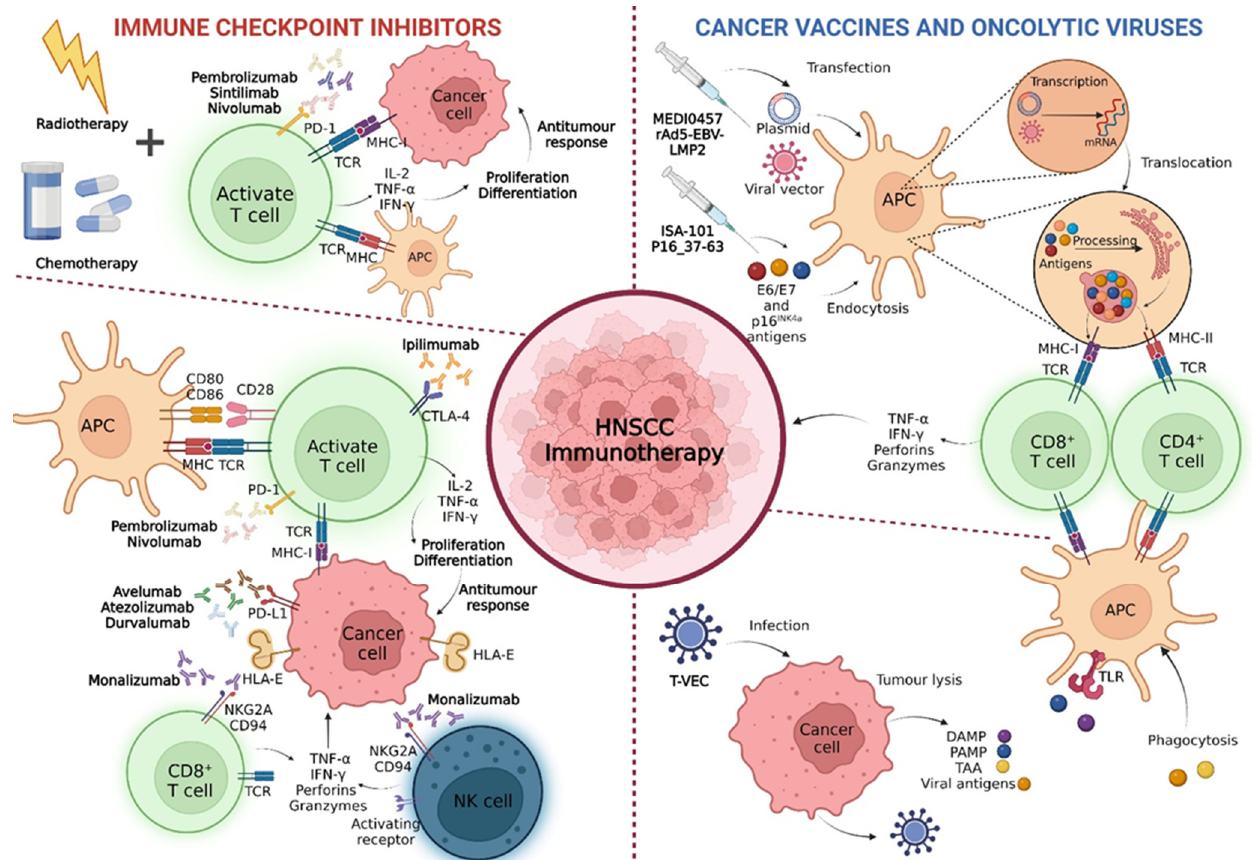
Figure 4. Immunotherapy in the treatment of patients with HNC. To prevent the development of autoimmune diseases due to the hyperreactivity of the immune system, T cells express inhibitor molecules on the surface: programmed death-1 (PD-1) and cytotoxic T lymphocyte antigen 4 (CTLA-4). From 50% to 60% of patients with head and neck squamous cell carcinoma express the PD-1 ligand in their tumour cells—programmed death ligand 1 (PD-L1). Upon this interaction, T cells suppress their cytotoxic activity and, consequently, promote tumour progression. Likewise, the interaction of CTLA-4 with the CD80/CD86 ligands expressed on antigen presenting cells (APC) prevents the proliferation and differentiation of T cells. NK group 2 member A (NKG2A) is a molecule expressed on natural killer and CD8 + T cells that, after interacting with HLA class I histocompatibility antigen, alpha chain E (HLA-E) present in tumour cells, recruits phosphatases to induce inhibitory signals to immune cells. In this sense, immunotherapy with antibodies directed to these molecules aims to reestablish the antitumour immunity in the same way as to promote tumour regression. Chemotherapy and radiotherapy can induce immunogenic cell death, and consequent activation of the adaptive immune response. Therefore, its combination with anti-PD-1 agents aims to improve the immune response. In addition to these strategies, therapeutic vaccines targeting Human Papilloma Virus and Epstein–Barr, and oncolytic viruses are other immunotherapeutic approaches on the rise. Nucleic acid vaccines, viral vector-based vaccines, and peptide vaccines integrate plasmids, viral vector, and viral antigens, respectively, into APC. In this way, the antigens will be processed and presented in the major histocompatibility complex (MHC) context, on the cell surface, stimulating cellular and humoral immunity. Talimogene laherparepvec (T-VEC), after infecting tumour cells from specific receptors, can replicate and induce lysis of these same cells. In this way, damage-associated molecular patterns (DAMP) and pathogens-associated molecular patterns (PAMP), as well as tumour- associated antigens (TAA) and viral antigens, are released into the medium. After their recognition by APC cells, immunity mediated by T CD4 + and T CD8 + cells are